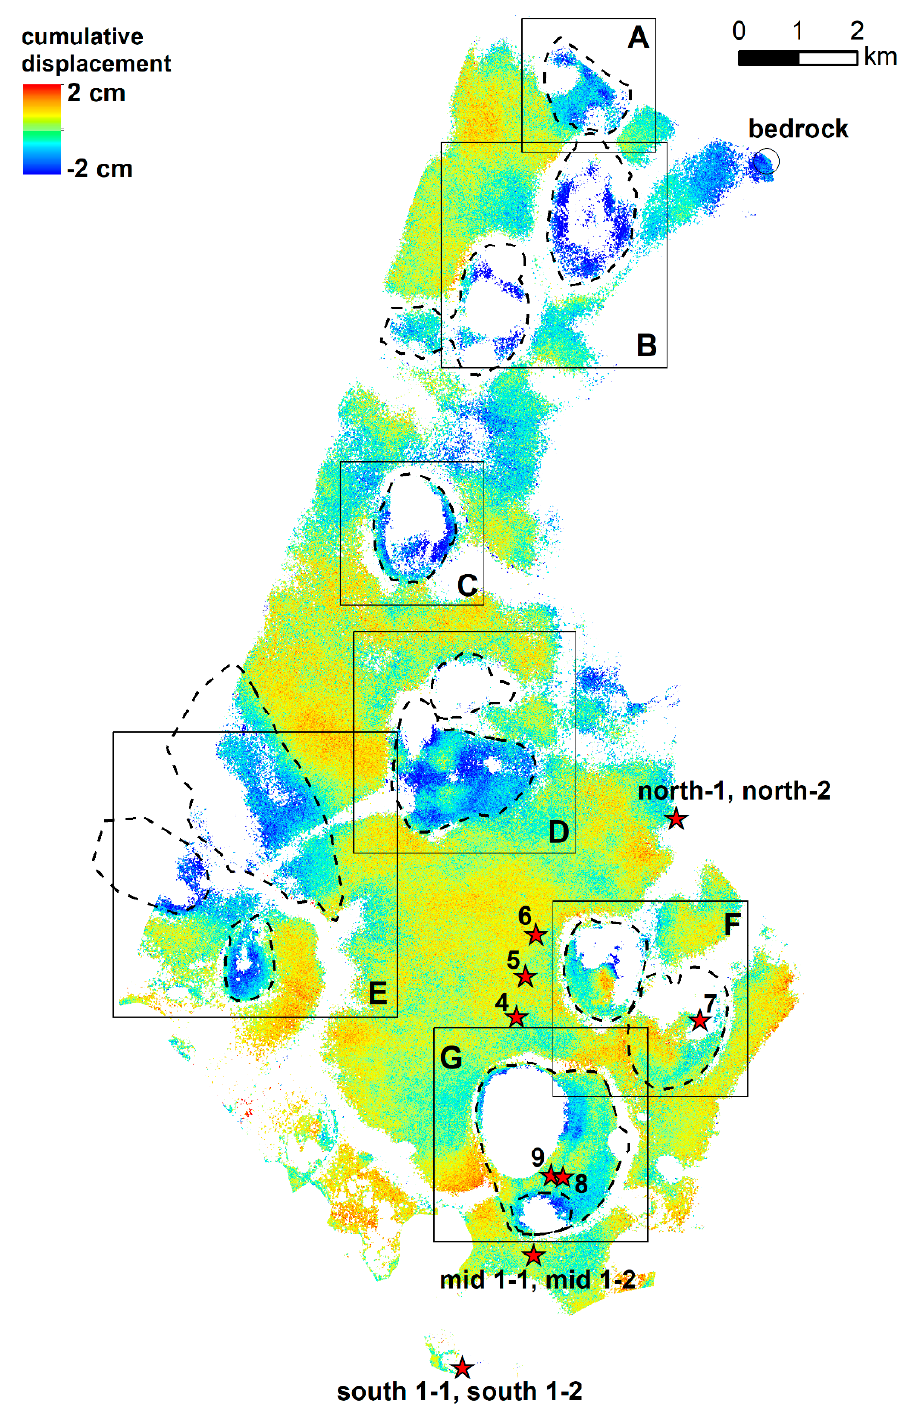
Figure 6. Deramped cumulative vertical displacement map (sum of eight sequential interferograms spanning from 7 June to 14 September 2013). Dashed lines delineate thermokarst basins. Lettered black boxes correspond to the areas shown in Figure 8. The open circle in north indicates a bedrock site that is used as reference point for the phase unwrapping. Locations of in situ measurements are depicted by red stars.